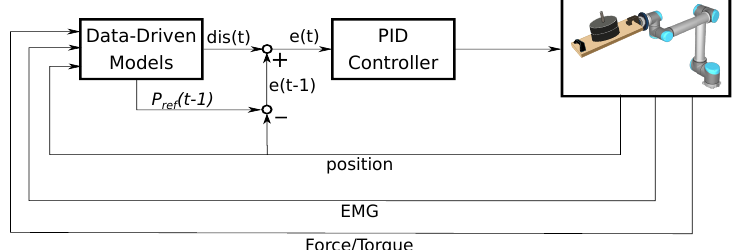
Figure 7. UR10 Position